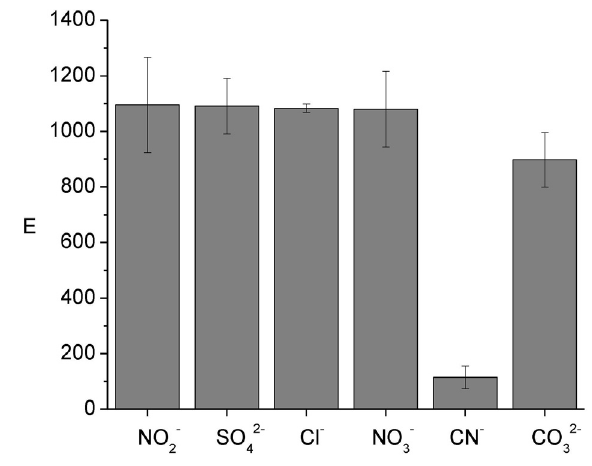
Figure 2. Influence of 50 mg L − 1 of NO the enrichment factor. Donor phase: 6.2 × 10 − 6 mol L − 1 Ni(II), 0.01 mol L − 1 MES, pH 6.6; acceptor phase: 0.01 mol L − 1 HCOOH, pH = 2; membrane phase: 0.012 mol L − 1 Kelex 100; 300 min of sampling time (n =